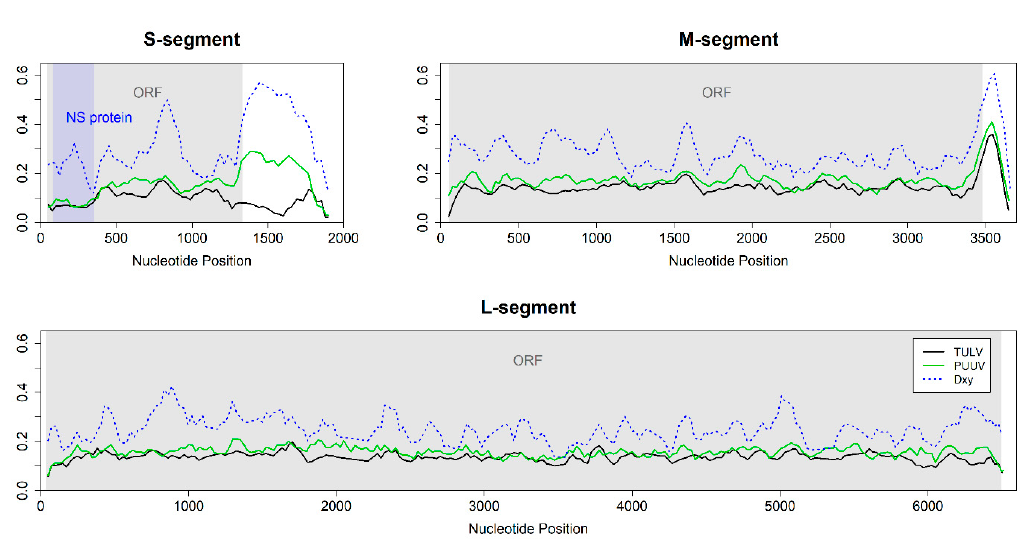
Figure 3. Sliding window analyses of nucleotide diversity (Pi) and the average number of nucleotide substitutions per site (D XY , blue line) between 20 TULV and 12 PUUV hantavirus genomes (window size 100 nt, step size 25 nt). The coding region / open reading frame (ORF) is indicated in grey. Genomic landscapes were similar between TULV and PUUV for the M- and L-segment but differed in the non-coding region of the S-segment. The nucleotide diversity within both TULV (black line) and PUUV (green line) was lower in the region encoding the non-structural (NS) protein (blue area) compared to the rest of the genome.